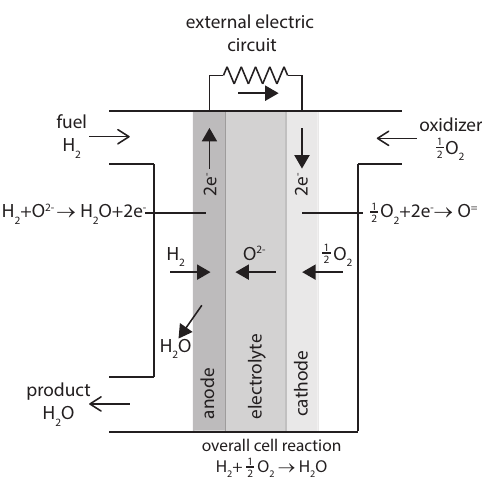
Figure A2. Schematic of a